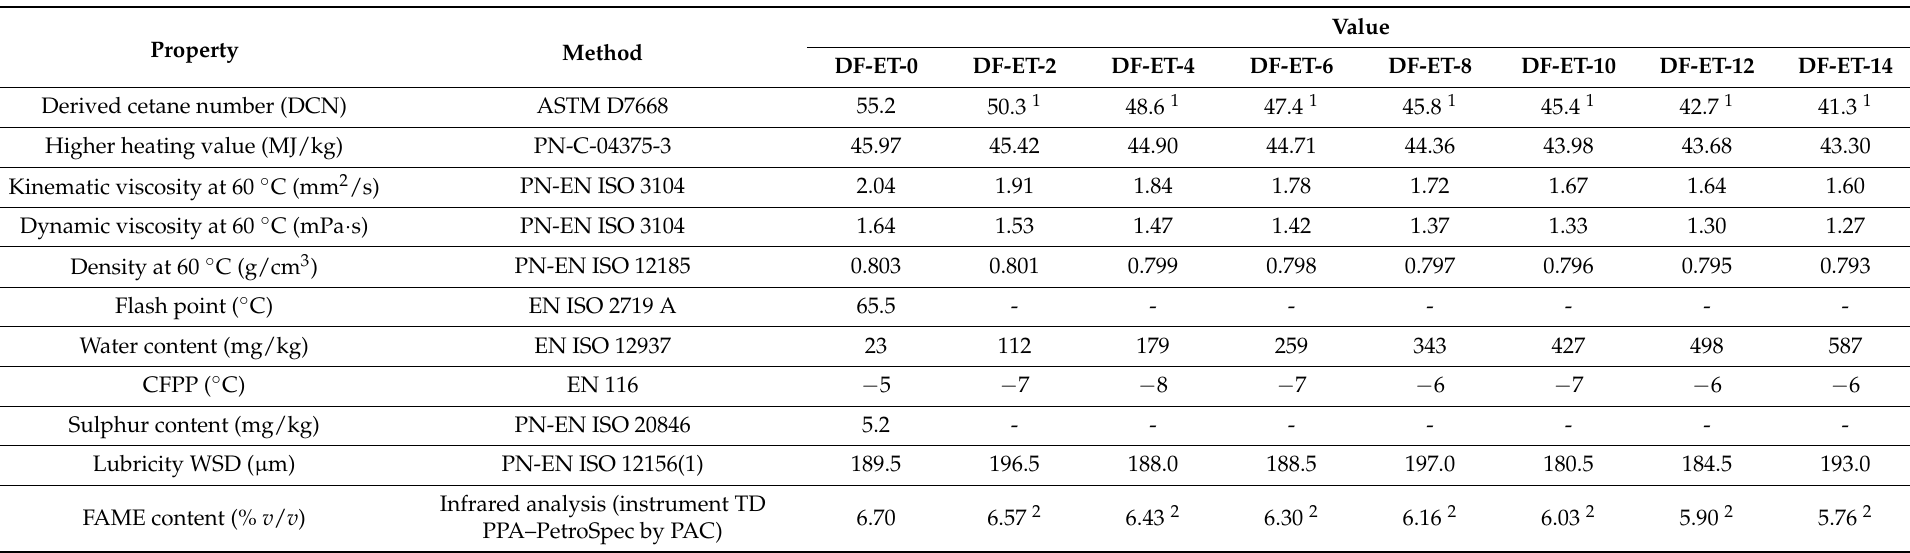
Table 4. Properties of the ethanol–diesel fuel blends used in the